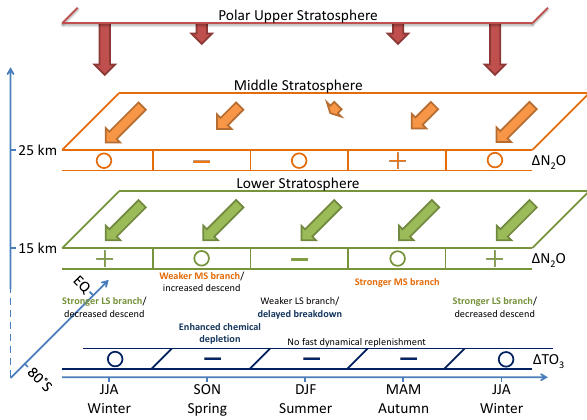
Figure 12: Sketch summarising the time evolution of the changes modelled (LS: lower stratospheric, MS: middle stratospheric). Arrows indicate a mean state. Deviations are indicated with + (positive), - (negative) and o (neutral).